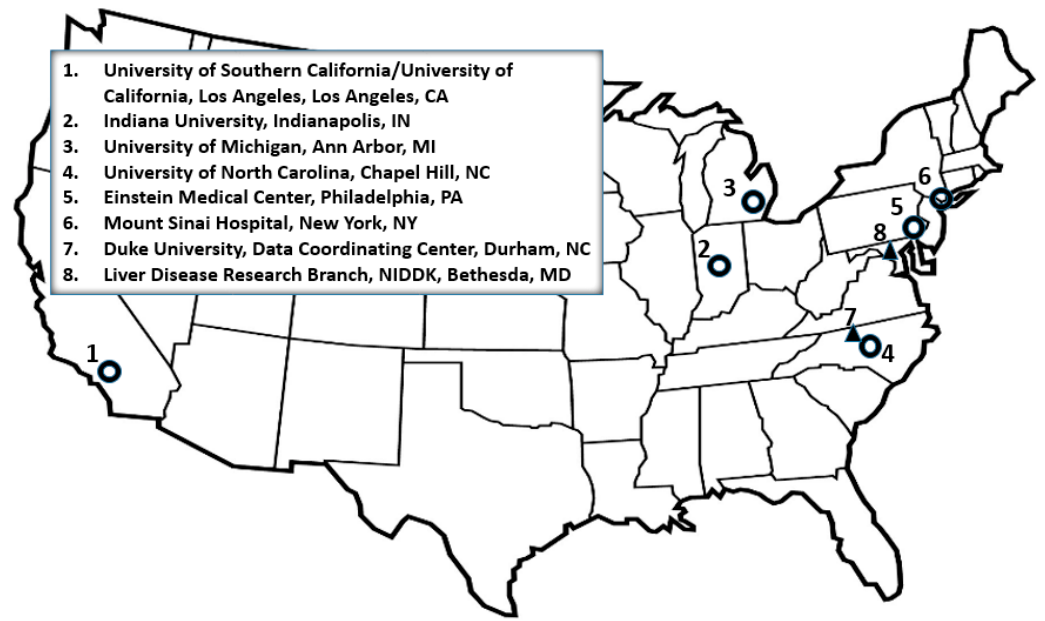
Figure 1. Drug-Induced Liver Injury Network (DILIN) 2015. NIDDK = National Institute of Diabetes and Digestive and Kidney Diseases.